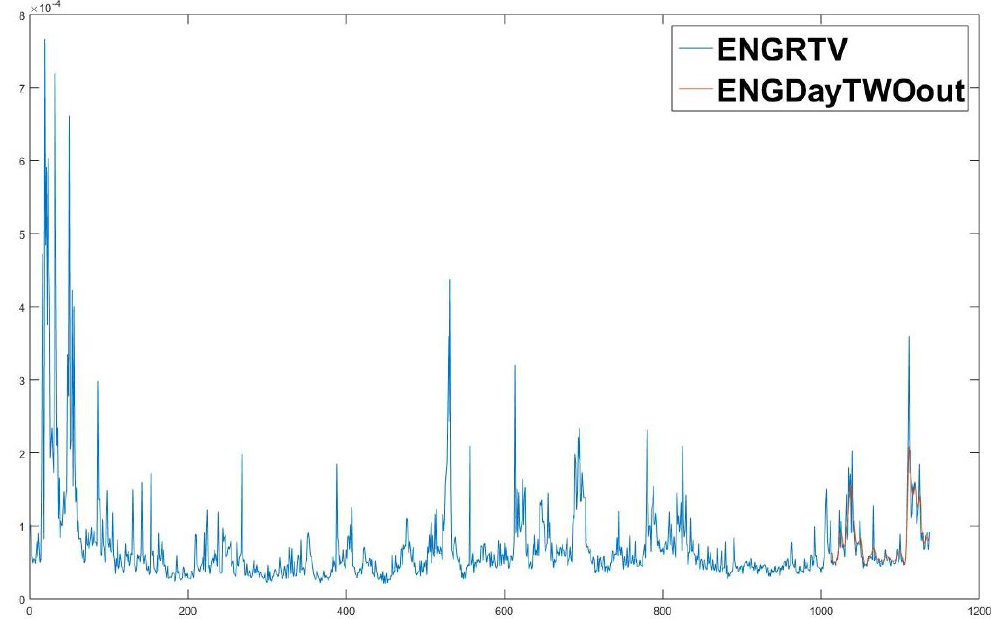
Figure 12. Model TWO-RTV-D Forecast for ENG. The horizontal line is the timeline, and the perpendicular line is the volatility estimator. The forecasted period is the last 124 days. The actual values are represented by the blue line, while the forecasted values are represented by the orange line. The forecasted values are close to the actual values, except for a sharp jump around the Day